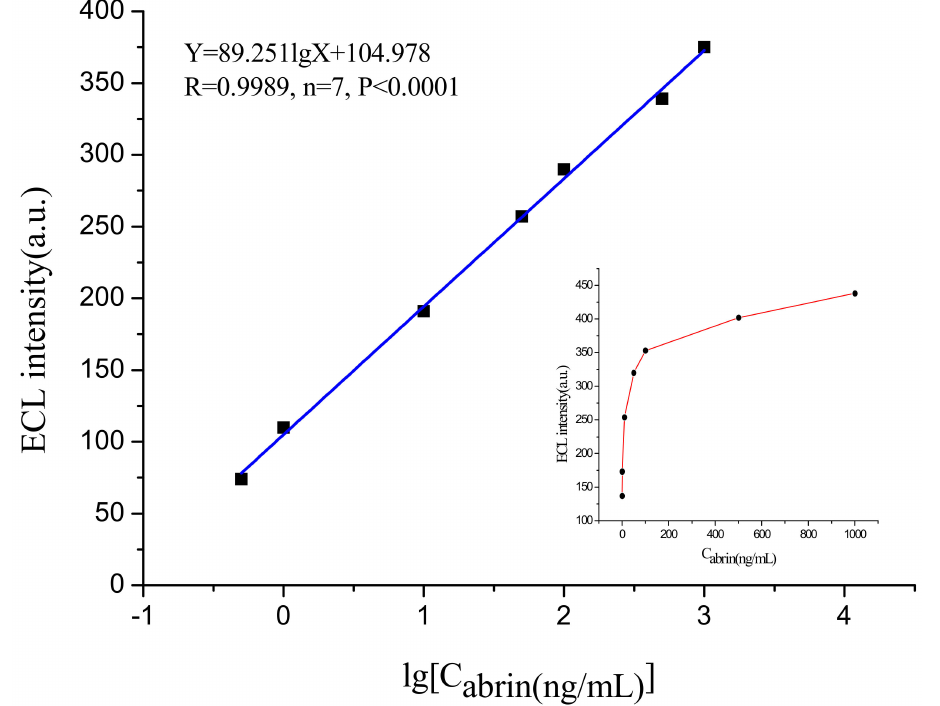
Figure 9. The relationship between ECL intensity and the concentration of